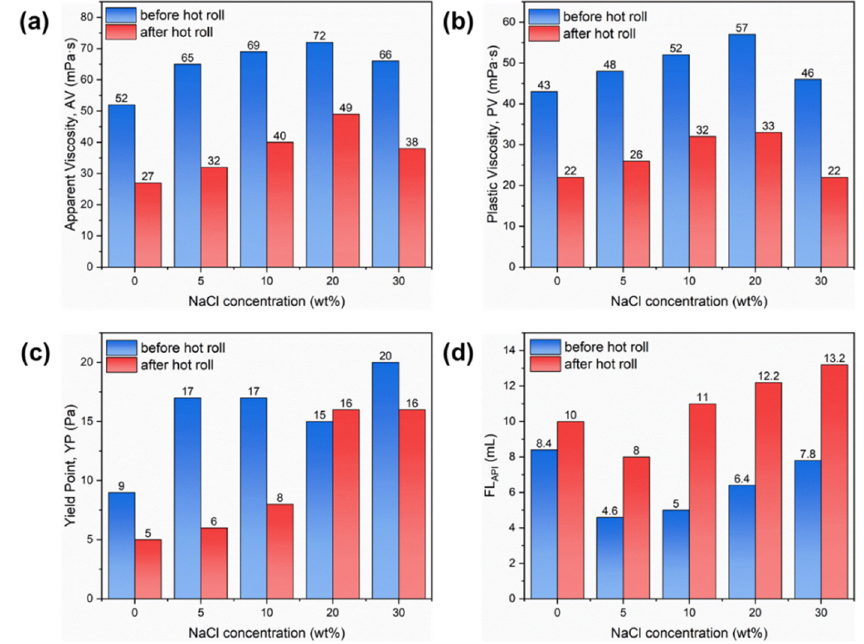
Figure 5. Rheological and fluid loss properties of 1 wt% PAND-based drilling fluid with different contents of NaCl before and after aging at 180 °C for 16 h: ( a ) apparent viscosity (AV); ( b ) plastic viscosity (PV); ( c ) yield point (YP); ( d ) fluid loss volume (FL API ).